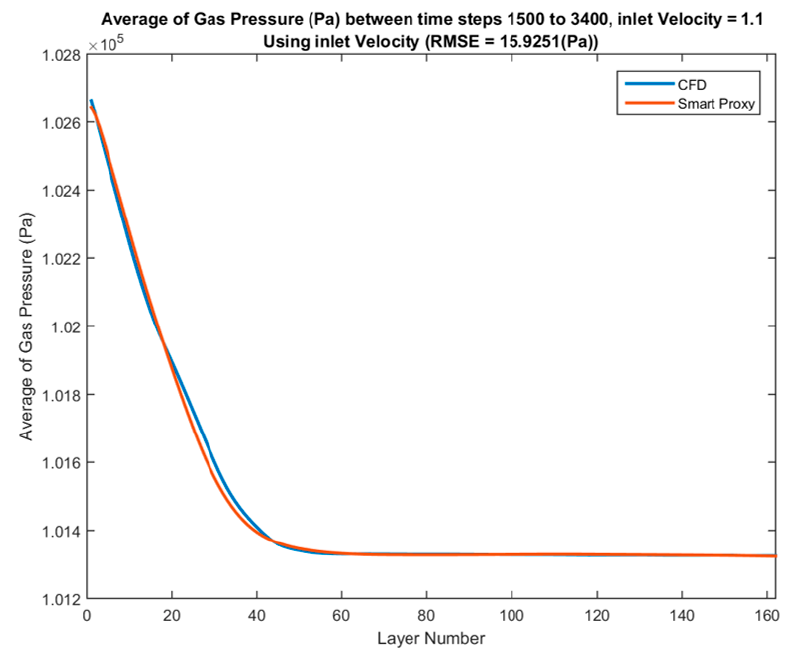
Figure 52. Spatial average profile of CFD and smart proxy results for gas pressure (Pa) averaged over time steps 1500 to 3400 for blind test condition of V in = 1.1 m/s.